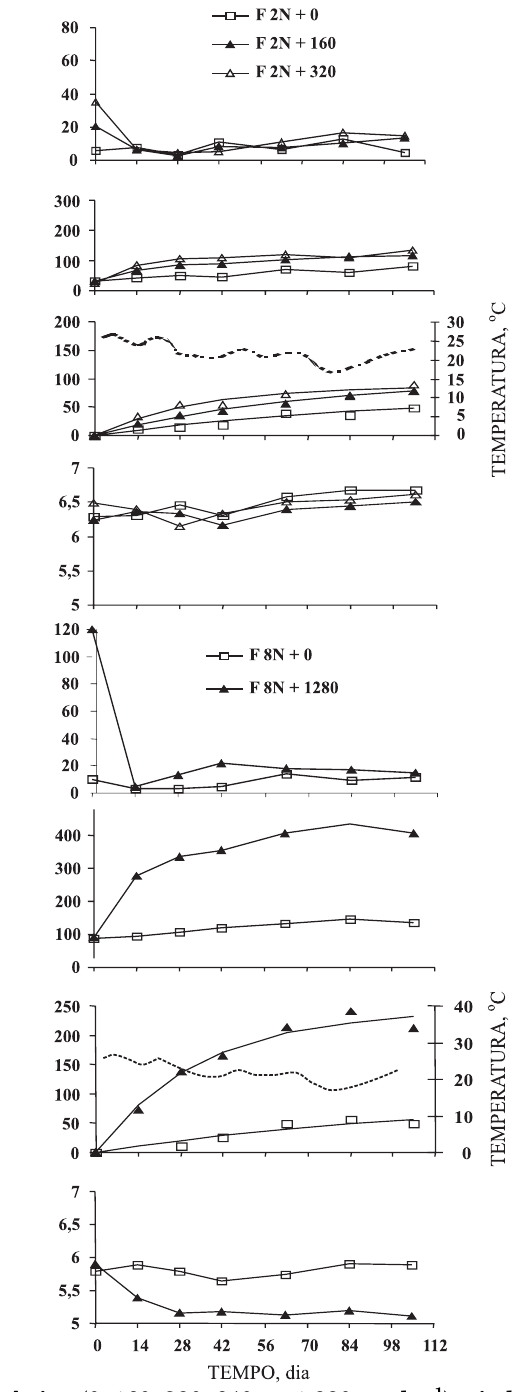
Figura 1. Efeito da quinta aplicação de doses de N orgânico (0, 160, 320, 640 ou 1.280 mg kg -1 ), via lodo de esgoto de Franca, sobre os teores de N amoniacal e nítrico, N mineralizado (Nm) e pH, durante incubação de Latossolo pré-tratado com o resíduo. F 1N representa o Latossolo pré-tratado, em quatro cultivos sucessivos, com a dose de lodo calculada para adubação nitrogenada de milho; F 2N, F 4N e F 8N representam seus